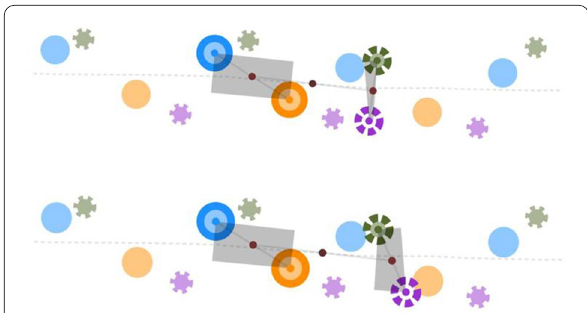
Fig. 9 The G3-0–50 ‘walking trot’ (upper) and the G2-1-50 walk (lower). Note the subtle difference in the position of the forelimbs and the roughly 20 cm difference in inferred trackmaker CL